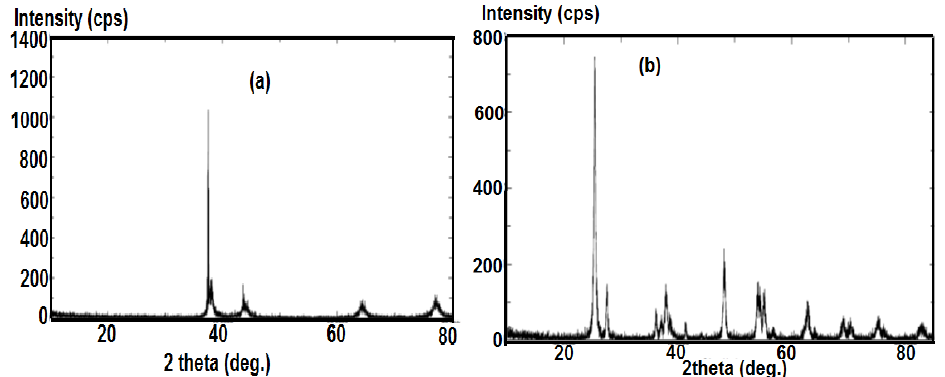
Figure 5. XRD patterns of citrate AgNP ( a ) before dispersion in 0.1 M HCl and ( b ) after dispersion in 0.1 M HCl for 40